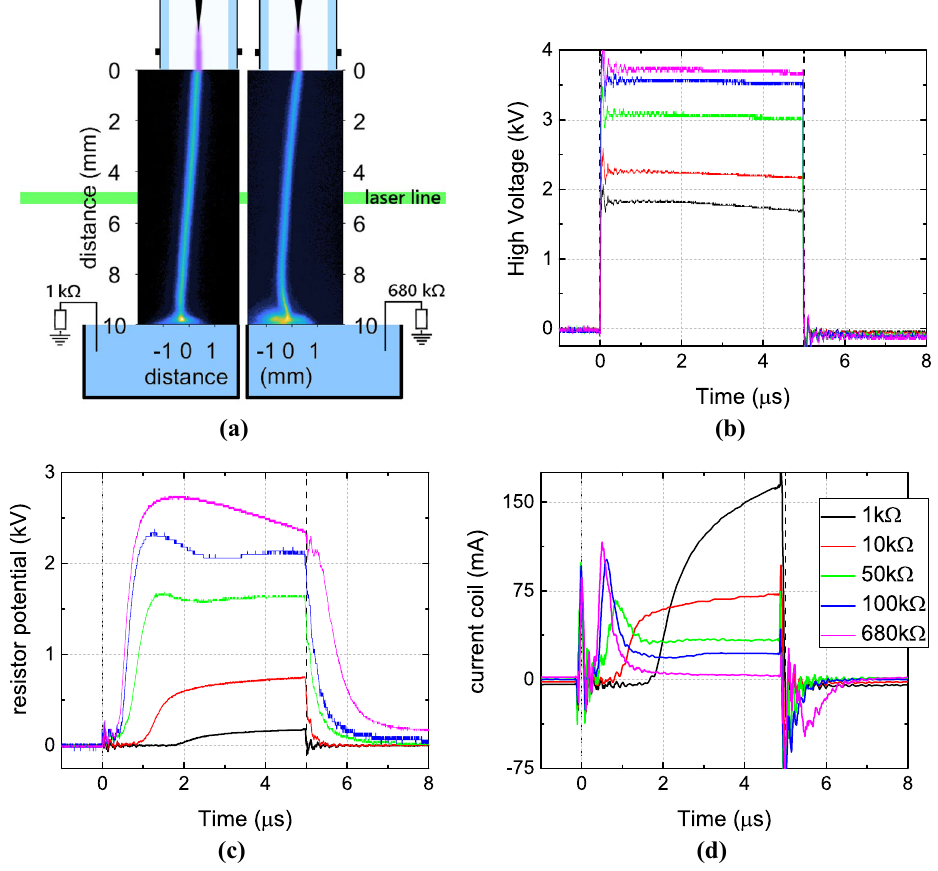
Figure 1. ( a ) two examples of the spatial profile of the light emission from the plasma discharge between the end of the capillary (at 0 mm) and the liquid (at 10 mm) for two cases of 1k (cid:31) and 680 k (cid:31) at specific times: respectively at 3.2 µ s and 5.6 µ s , using 10 ns exposures. The sketch of the jet and liquid target are present for visualization purposes and therefore out of scale. The waveforms for all five examined cases of varying resistance are shown in ( b ) for the high voltage, ( c ) the potential at the grounded resistor, and ( d ) the current measured with the Rogowski